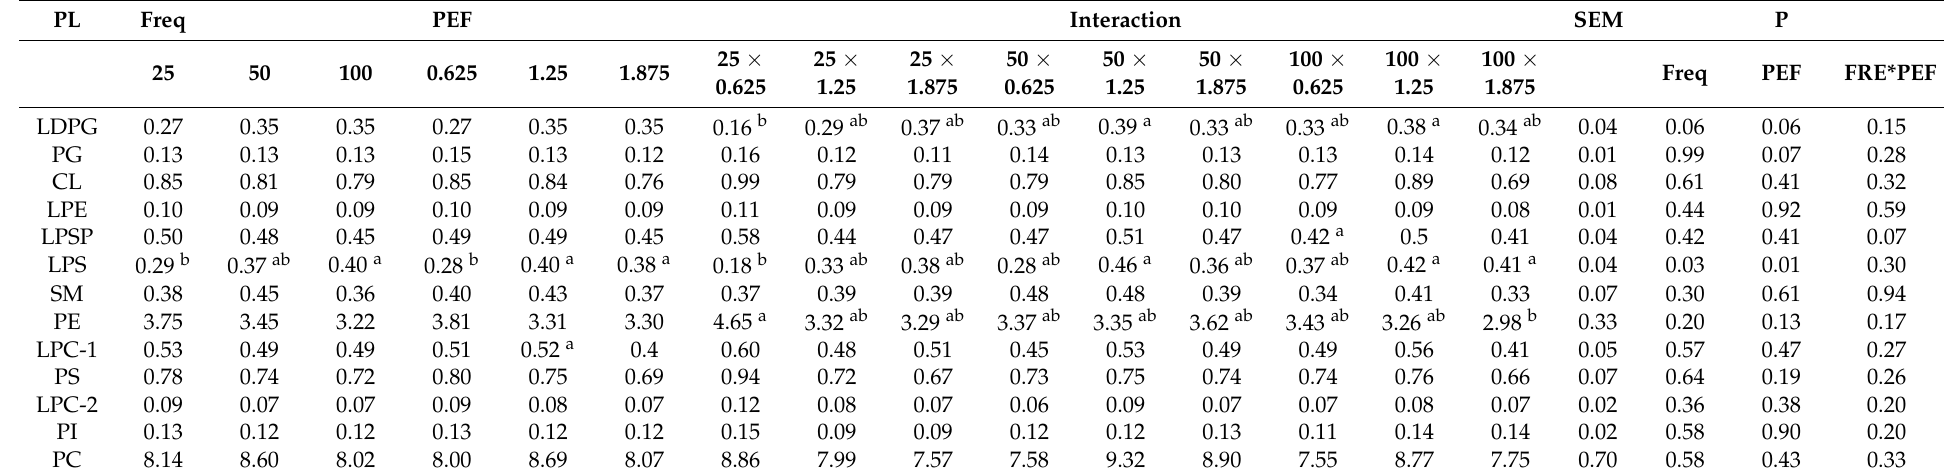
Table 6. Phospholipid composition of HMG pre-treated with